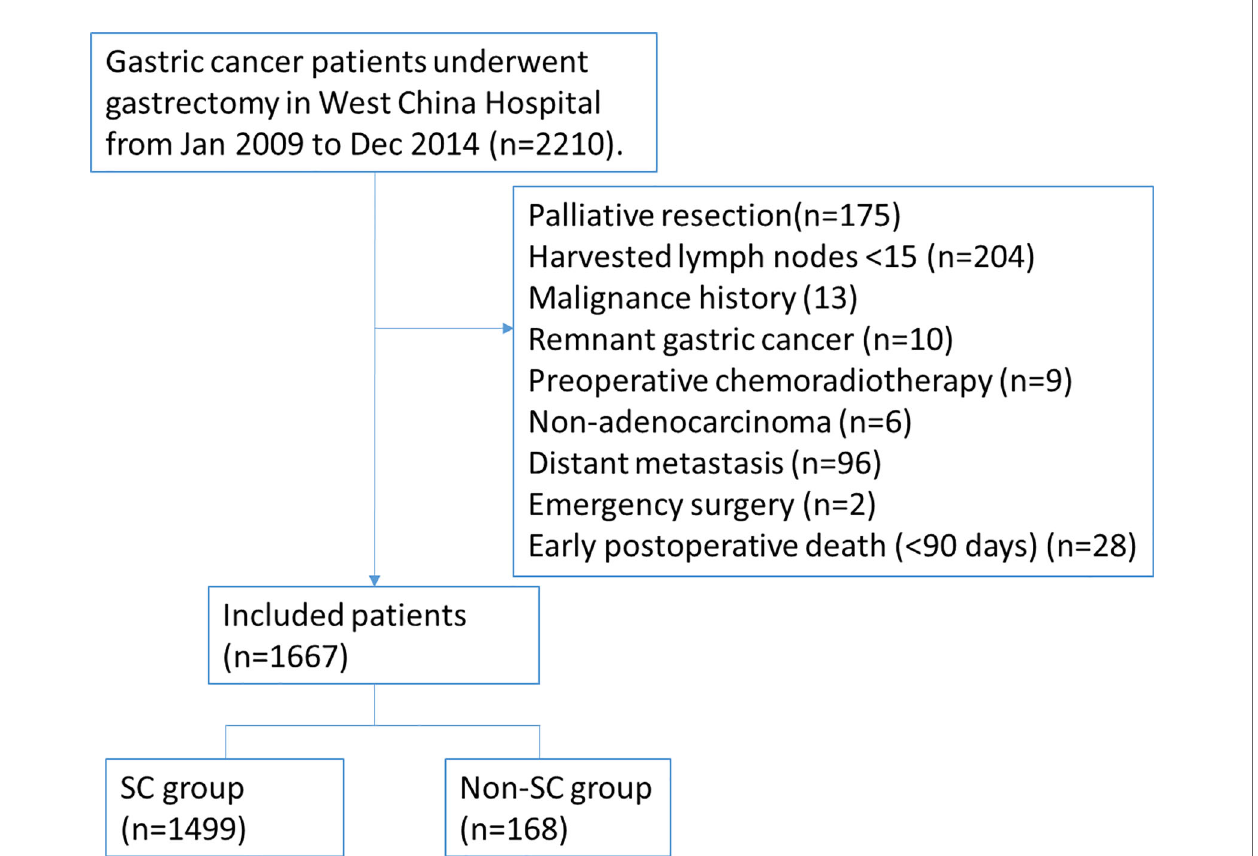
FIGURE 1 | The fl ow diagram of gastric cancer patients enrolled in this